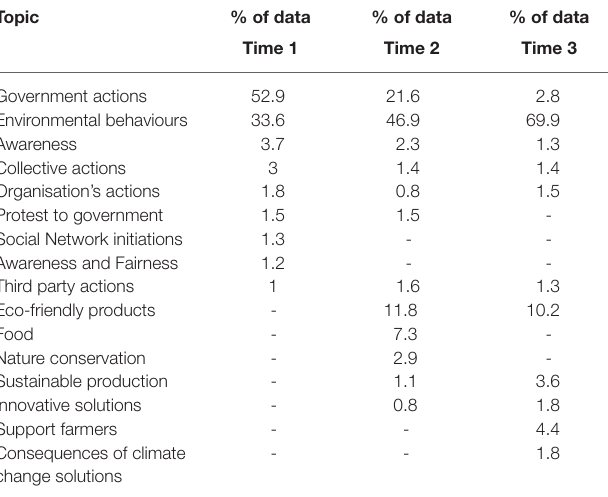
TABLE 3 | Salience of topics for each set of tweets.